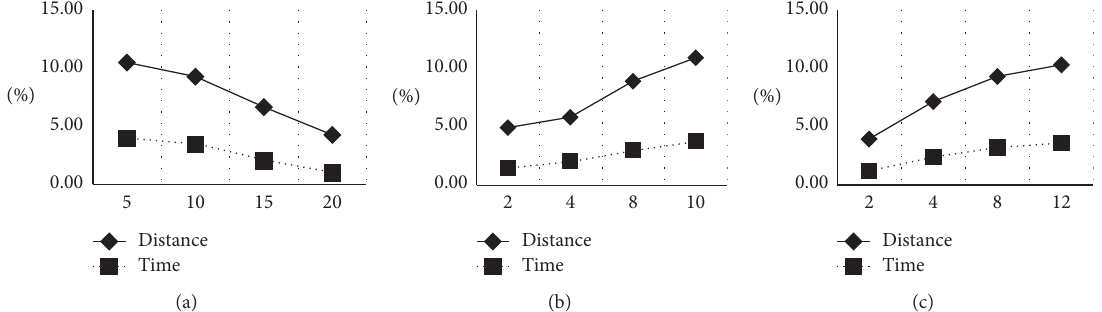
Figure 6: Optimization effect of DSLA: (a) average order size, (b) strength of demand correlation, and (c) adjustment